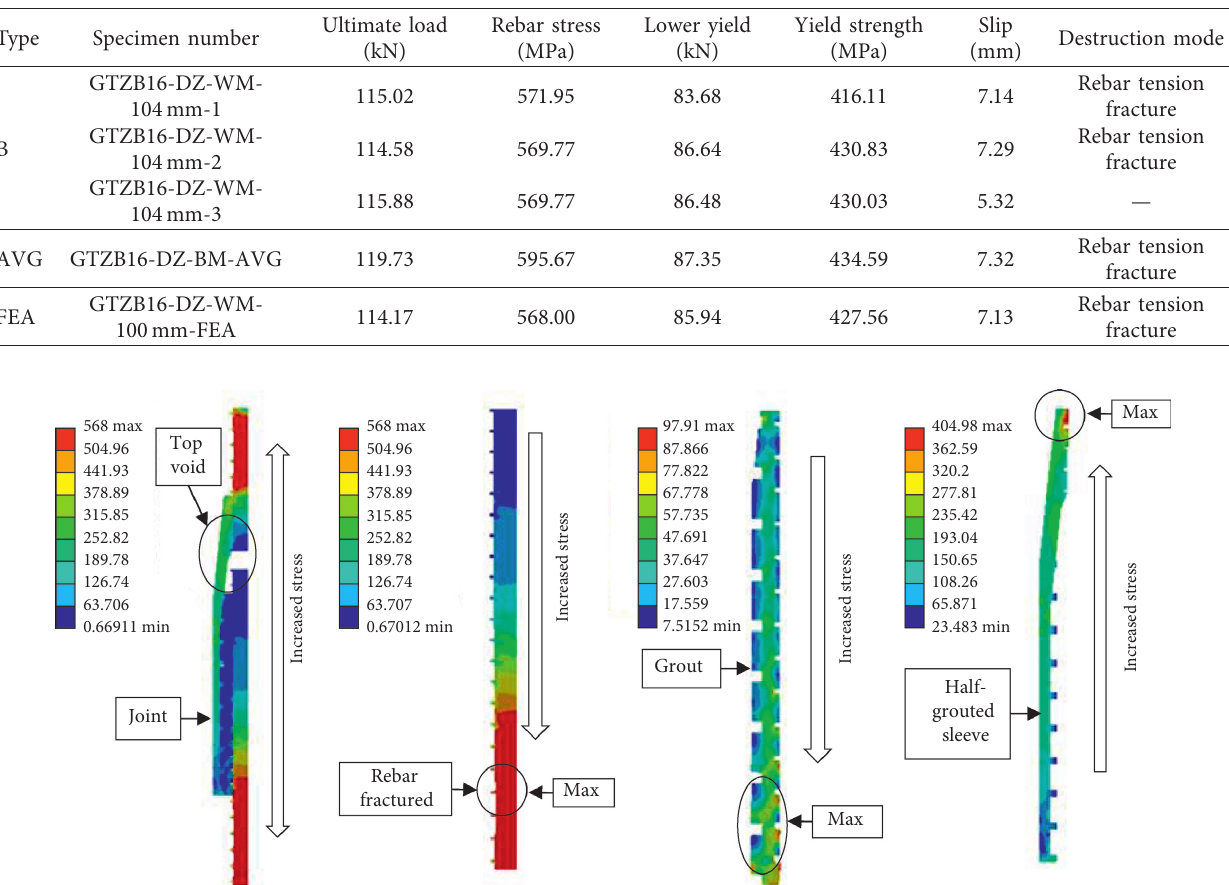
Table 5: The experiment and stimulation data of the insufficient grouting height specimen (104mm: 6.5d).